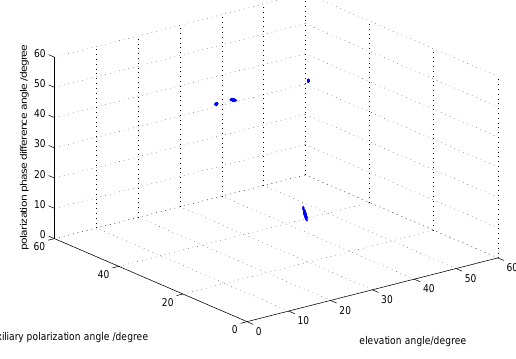
Figure 7. The DOA and polarization estimation before the filtering with fixed SNR